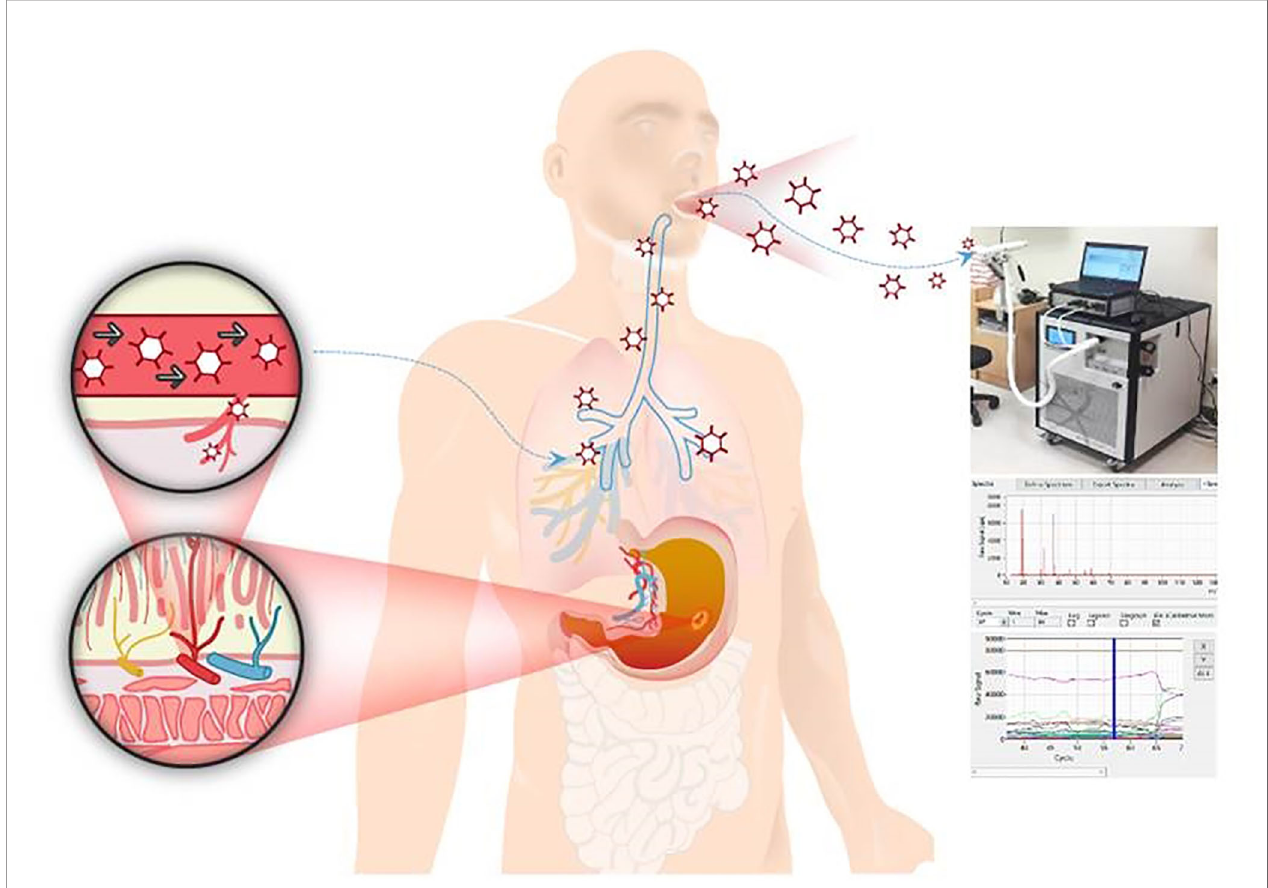
FIGURE 1 | The analysis of volatile organic compounds (VOCs) from exhaled breath via Proton-transfer-reaction time-of- fl ight mass spectrometry (PTR-TOF-MS). This analysis is based on the concept that VOCs are not derived directly from the lung or GI organs but from the metabolic origin through the blood circulating system. Participants ’ exhaled breaths samples were repeatedly collected through the mouth inlet of